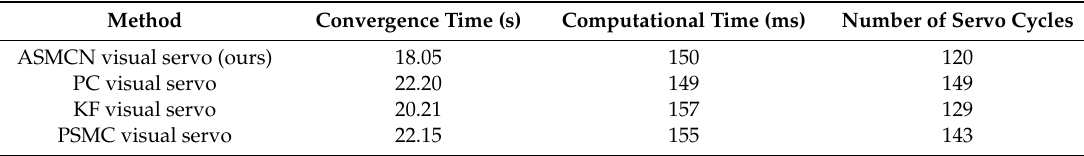
Figure 8. Comparison result of accumulated visual errors. Table 1. Quantitative comparison result.